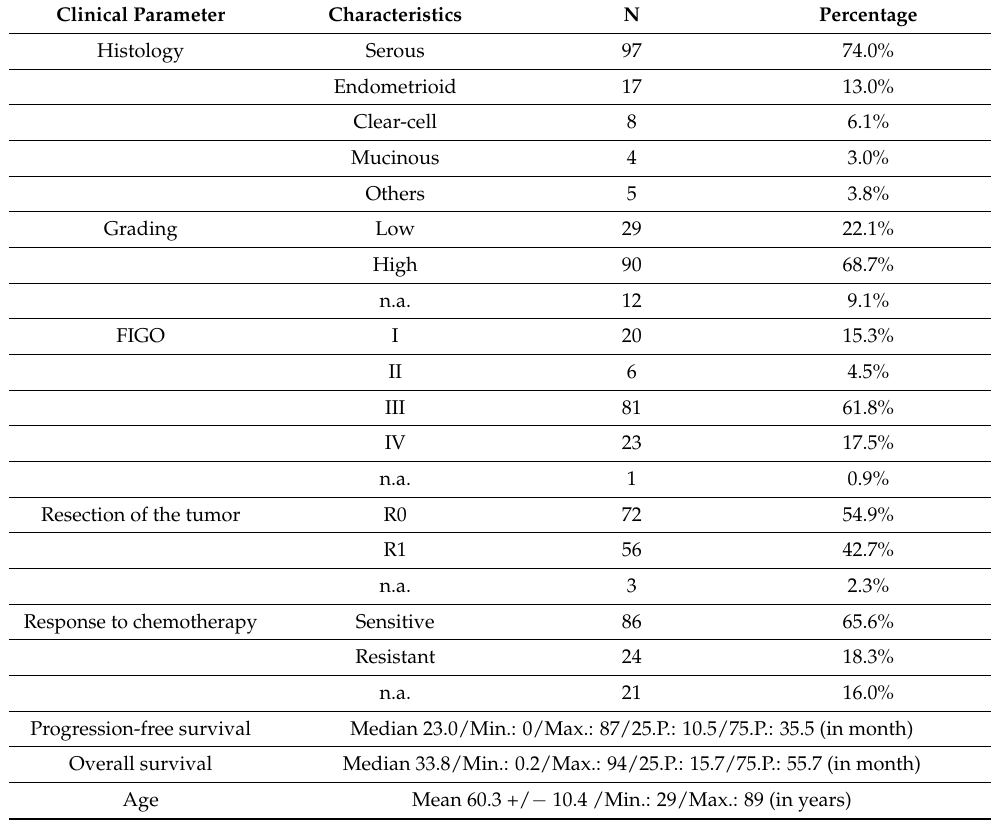
Table 1. Clinical parameters of the patient cohort. Shown in the table: Histology of tumor, tumor grading, FIGO stage, resection of tumor mass under surgery, response to chemotherapy, overall survival (OS), progression-free survival (PFS) and age. Not applicable (n.a.). Clinical Parameter Characteristics N Percentage